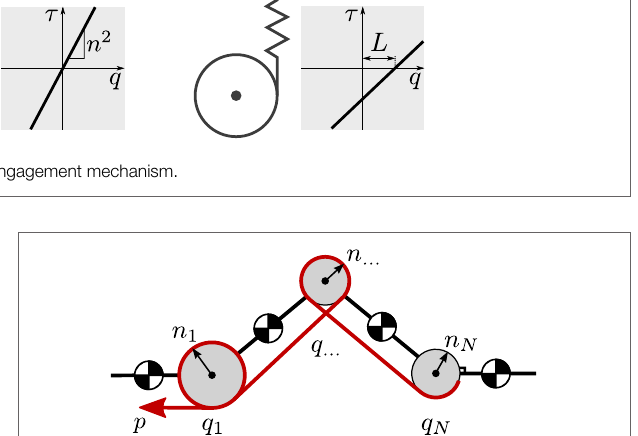
which is a function of n , hence the adjustment is not linear. It can be observed the first term results in a change in offset of (cid:28) for p ̸ = 0, and the second term shows that the change of slope of (cid:28) ( q ) scales with 2 n . As noted before, for n = 0 → (cid:28) = 0, allowing to effectively disengage the compliant